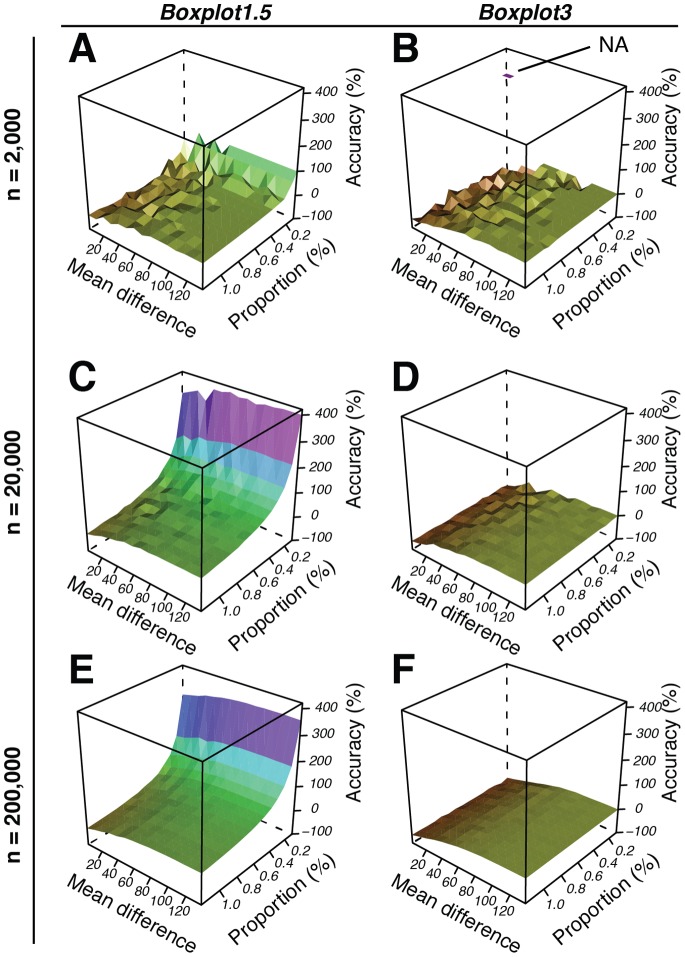
Same as Figure 7 but as a result from a simulation focusing on subpopulations with small proportions (range: 0.1–1.2%).Each surface is constructed from 250 data points, stemming from population separations of population mixtures with varying subpopulations with 15 different mean difference values (range: 2–137) and 15 different proportion values (range: 0.1–1.2%) at a constant standard deviation of 38.6. (A, B): Simulation was performed with population mixtures with n = 2000. (C, D): Simulation was performed with population mixtures with n = 20,000. (E, F) Simulation was performed with population mixtures with n = 200,000.